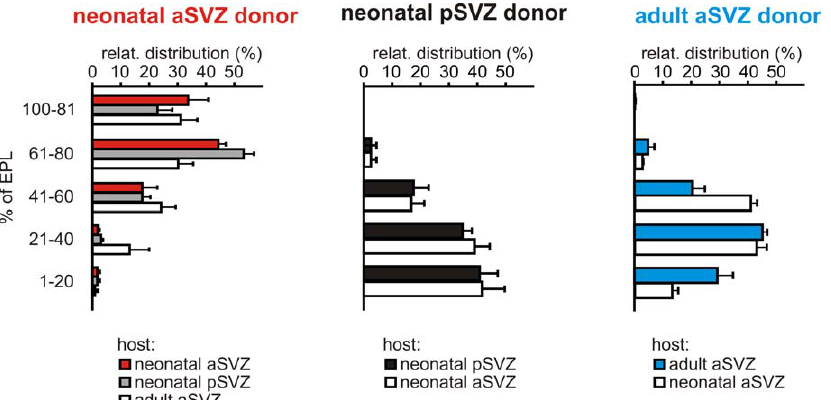
Figure 7. Lamina-Specific Distribution of GC Spines in the EPL Is Maintained after Transplantation Relative distribution of GC spines in the EPL from aSVZ or pSVZ of neonatal, and aSVZ of adult donors (for the neurons reconstructed in Figure 6.).